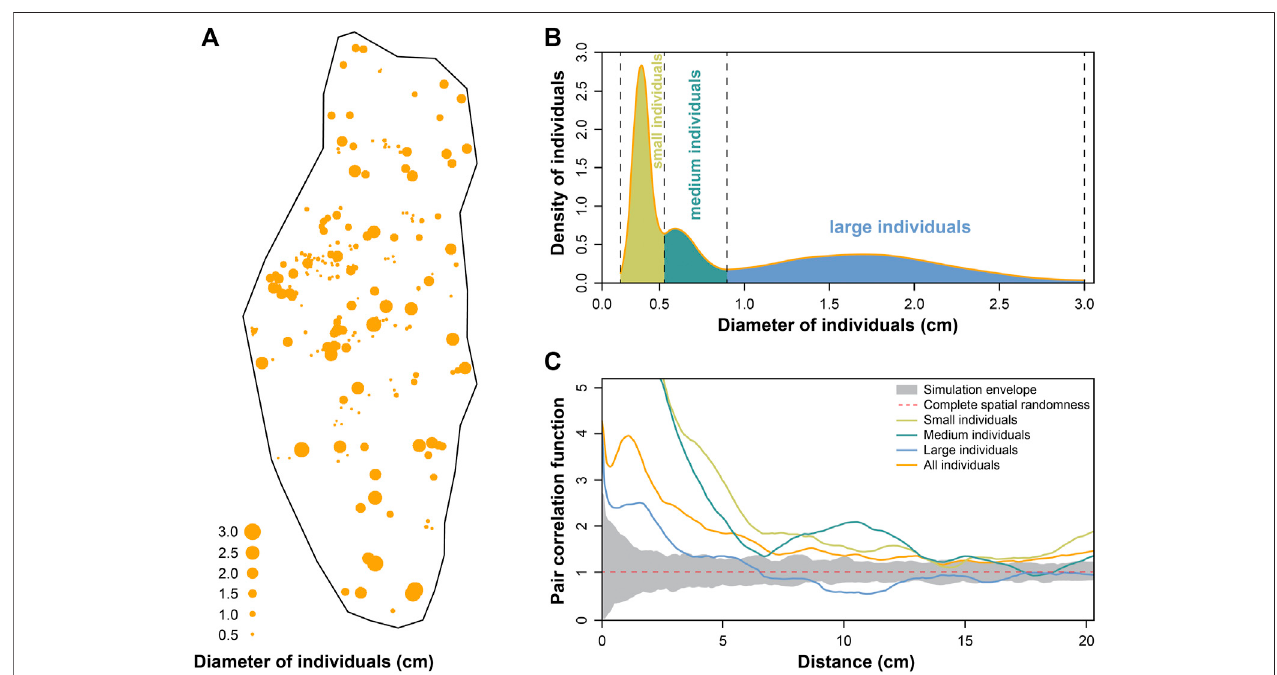
FIGURE3| Spatialdistributionof Beltanelliformiskonovalovi sp.nov. (A) SchematicmapoftheBSsurfacewithpositionsofindividualsandtheirdiameters. (B) Plot oftheestimateddensityofindividualsandtheirdiameters. (C) Plotsofpaircorrelationfunctionsdescribingthespatialdistributionsofallpopulationandthreedistinctsize groupings in comparison with the random distribution (999